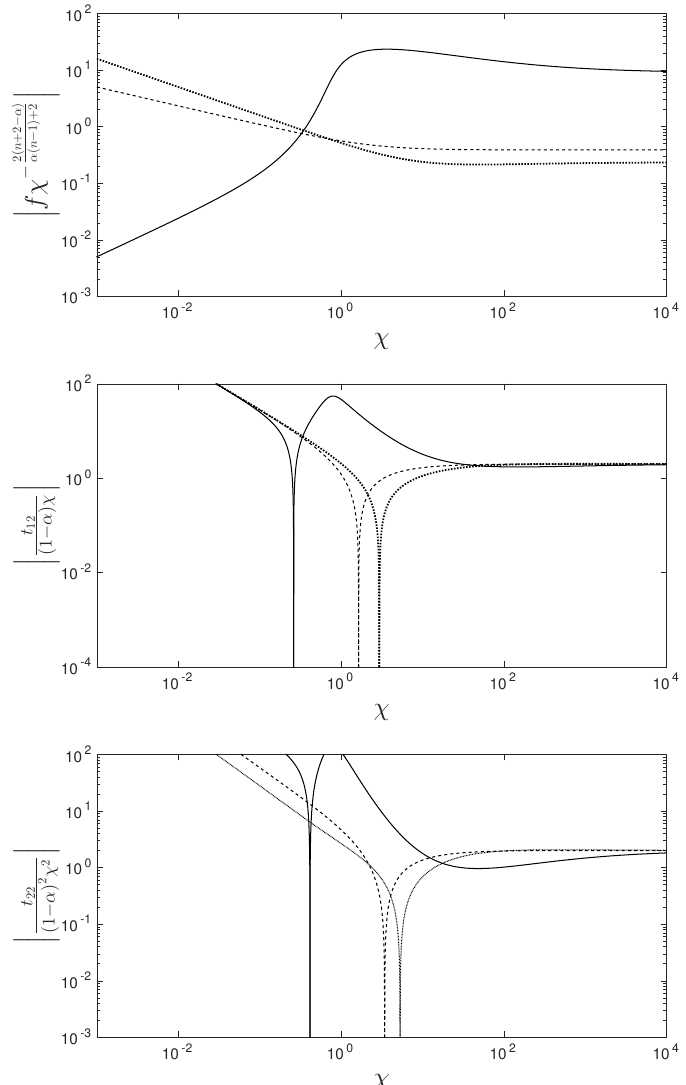
1 and p 0 = 1 for q = n . −